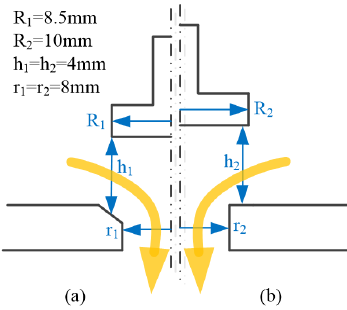
Figure 3. Structure of the gas fuel injector: ( a ) Push-open injector; ( b ) Pull-open injector.